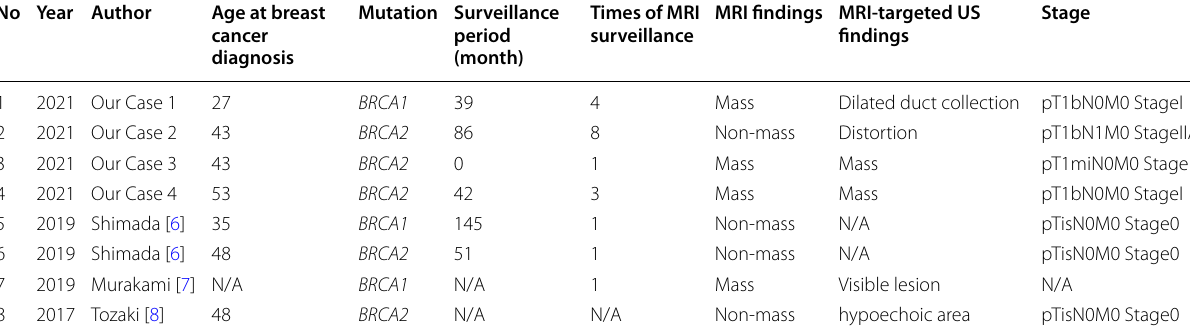
MRI magnetic resonance imaging, US ultrasonography, N/A not